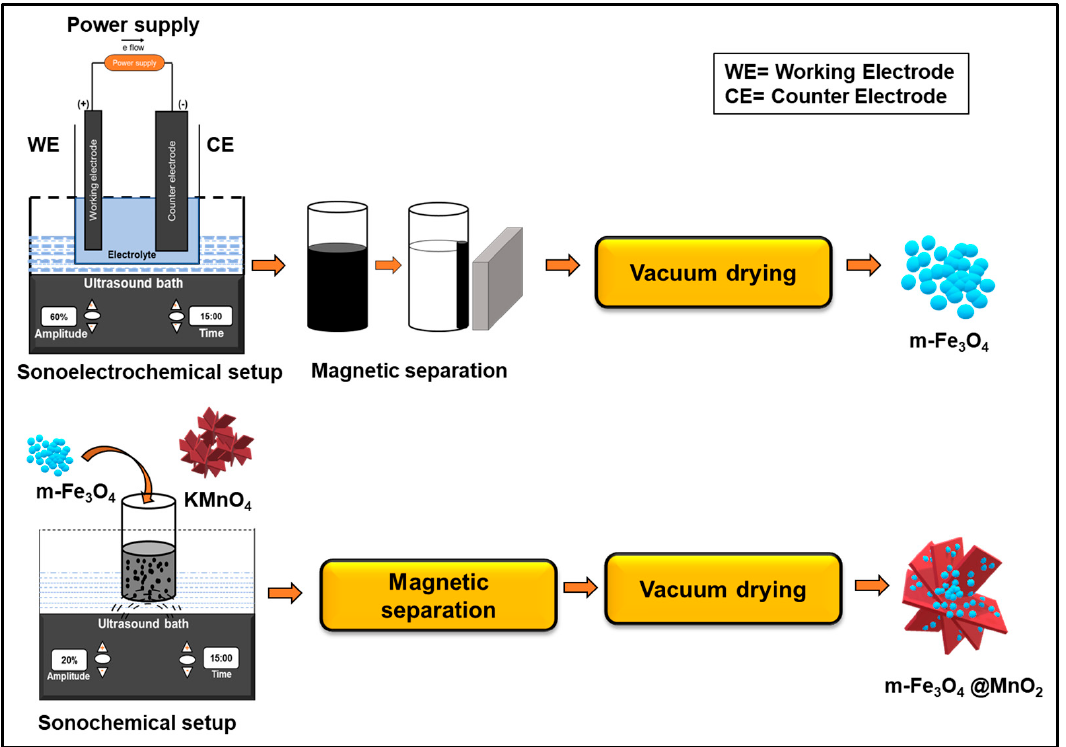
Figure 1. Schematic representation of experimental setup for m − Fe 3 O 4 @MnO 2 nanoarchitectonics.